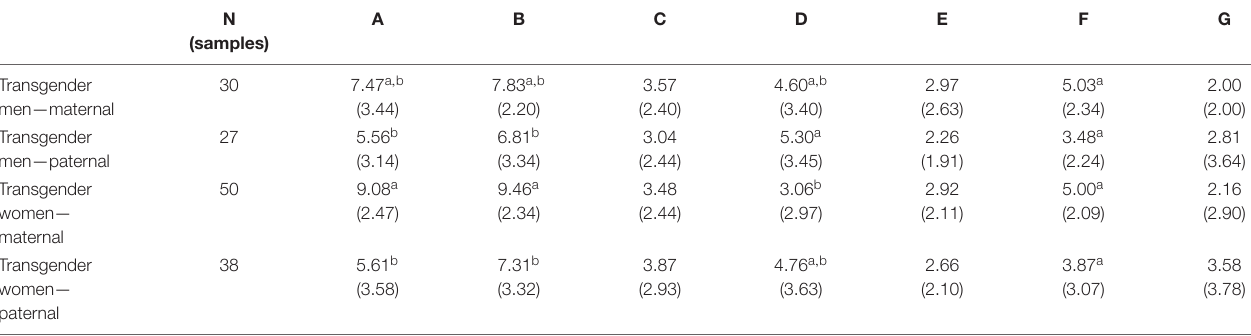
TABLE 3 | Average and standard deviation of maternal and paternal (PSI).